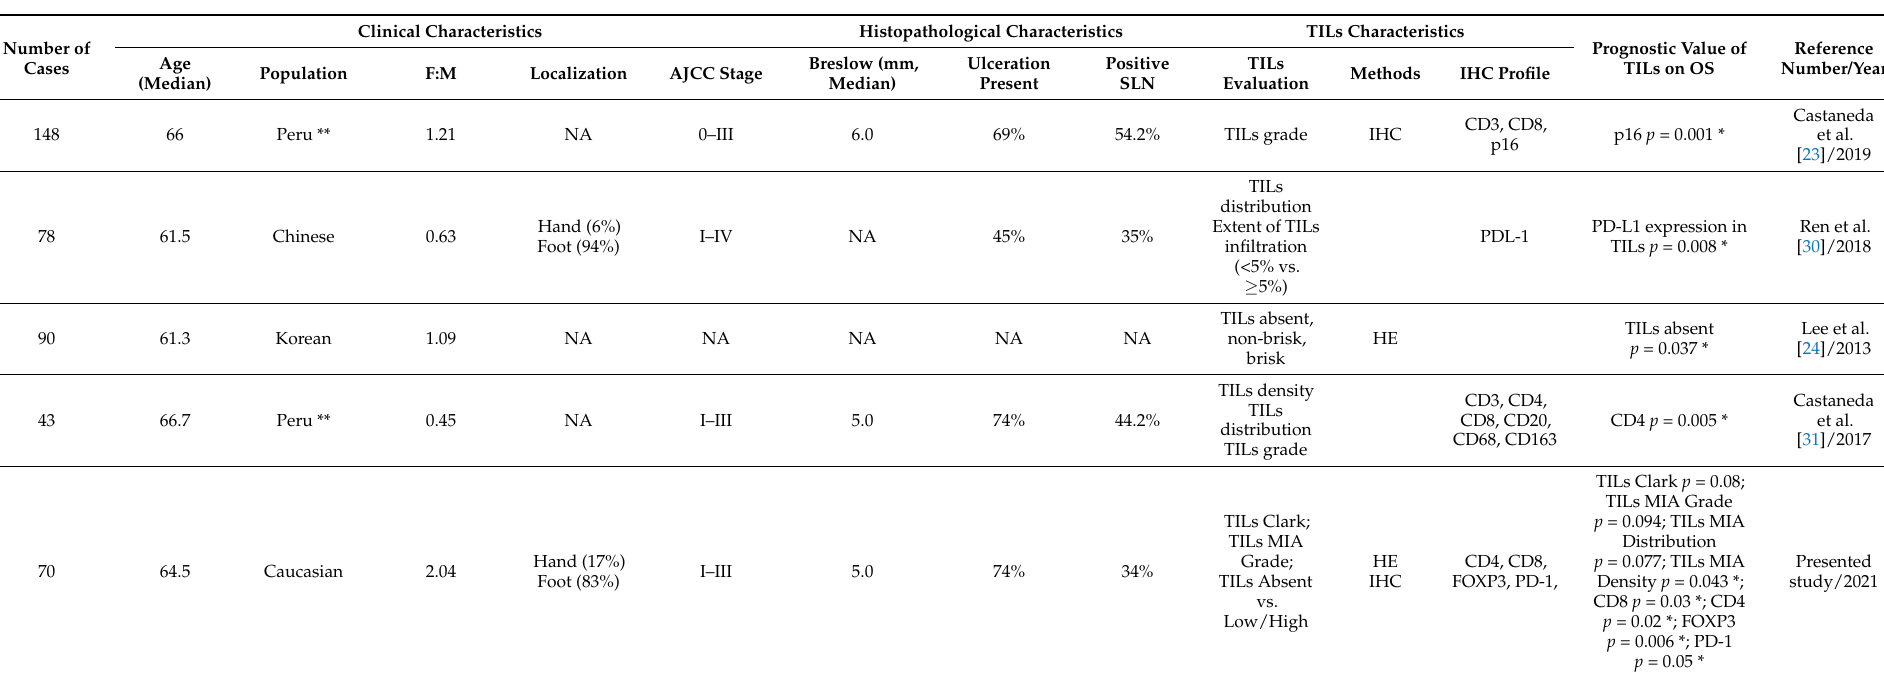
Table 6. Summary of studies addressing TILs in acral melanoma. Statistical significance ( p ≤ 0.05) is marked with *. The acral lentiginous melanoma (ALM) patient populations are marked with